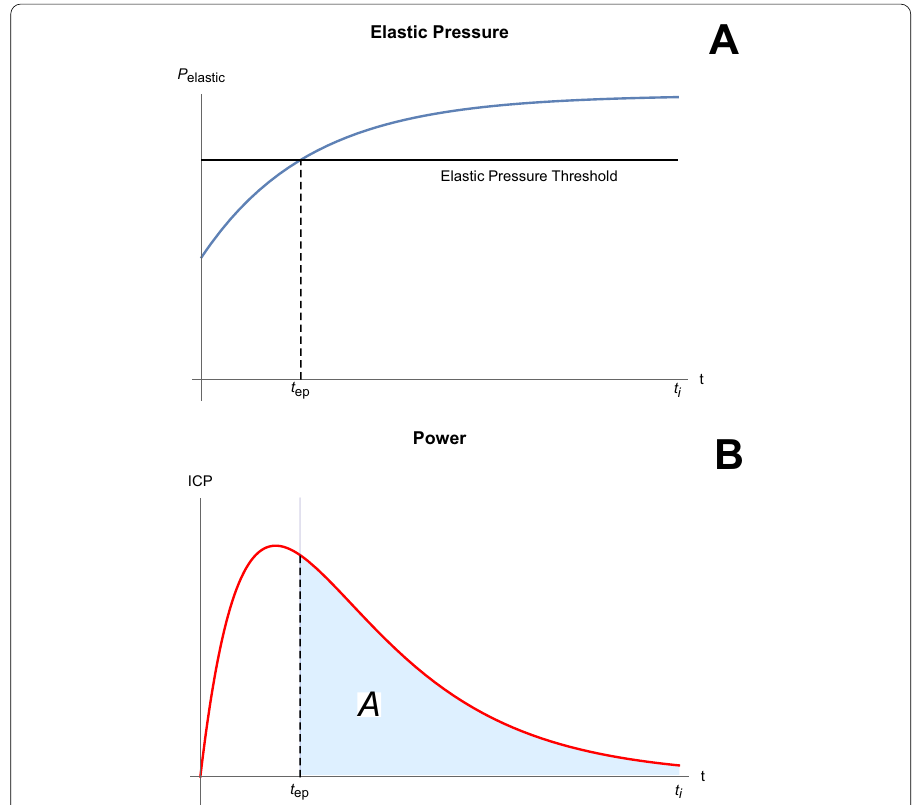
Fig. 1 Schematic depiction of elastic pressure ( a ) and intracycle power ( b ) as functions of inspiratory time ( t i ) for the Pset flow profile at PEEP 0 cmH 2 O. Note that the concept illustrated here in generic form applies = equally well to total intracycle power and to its driving elastic and dynamic elastic components. As the lung inflates, elastic pressure reaches a pressure threshold at time t ep beyond which further increments of power have potential to contribute to damage. Although PEEP is assumed to be zero in this illustration for clarity, identical principles apply when PEEP is